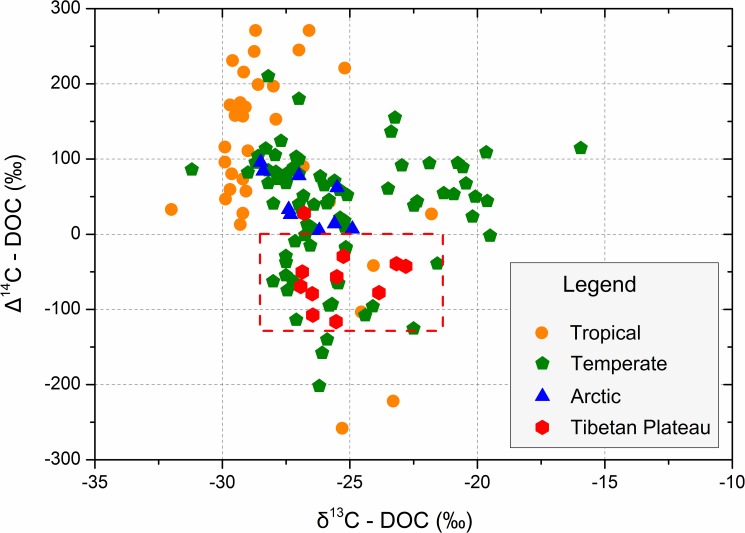
Distributions of Δ14C and δ13C isotopes of dissolved organic carbon for rivers of the Tibetan Plateau and other regions.A full reference list for the carbon isotopes data is provided in Data Set 1.